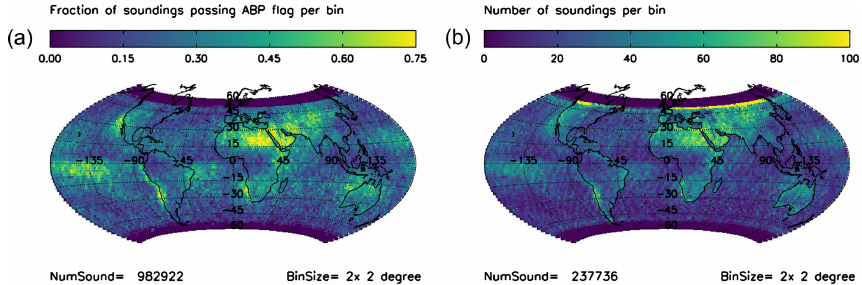
Figure 12. Maps of the annual fraction of soundings passing the ABP cloud flag (a) and the resultant clear-sky sounding density (b) binned 2 ◦ × 2 ◦ latitude. Number densities should be inflated by 240 to provide a real estimated number of soundings at the full spatiotemporal